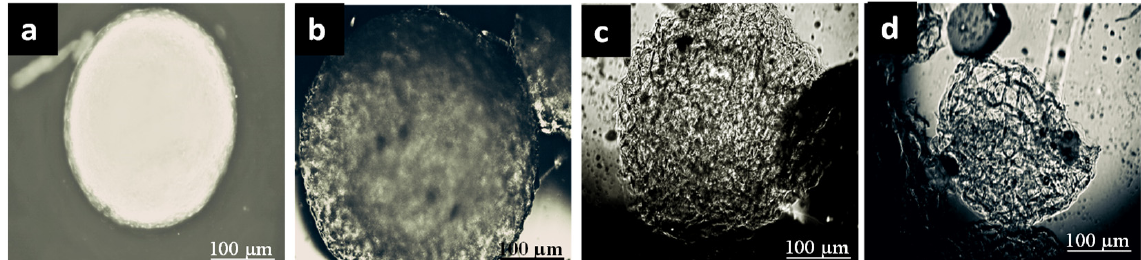
Figure 2. Optical images of insulin-loaded AX microcapsules during transit in the simulated stomach ( a ), small intestine ( b ), and ascending colon after 6 h ( c ) and 12 h exposure ( d ).